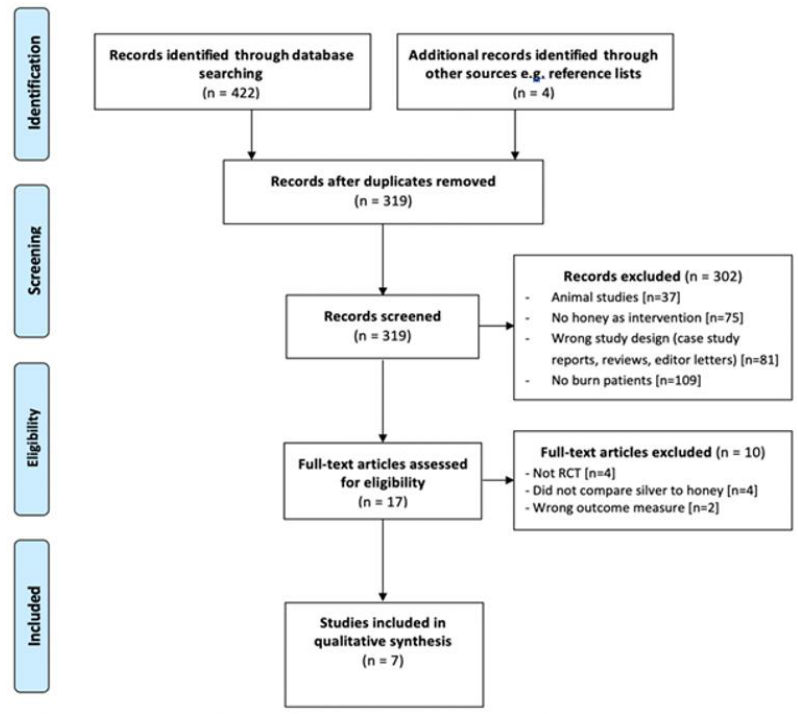
Figure 1. PRISMA flow diagram.